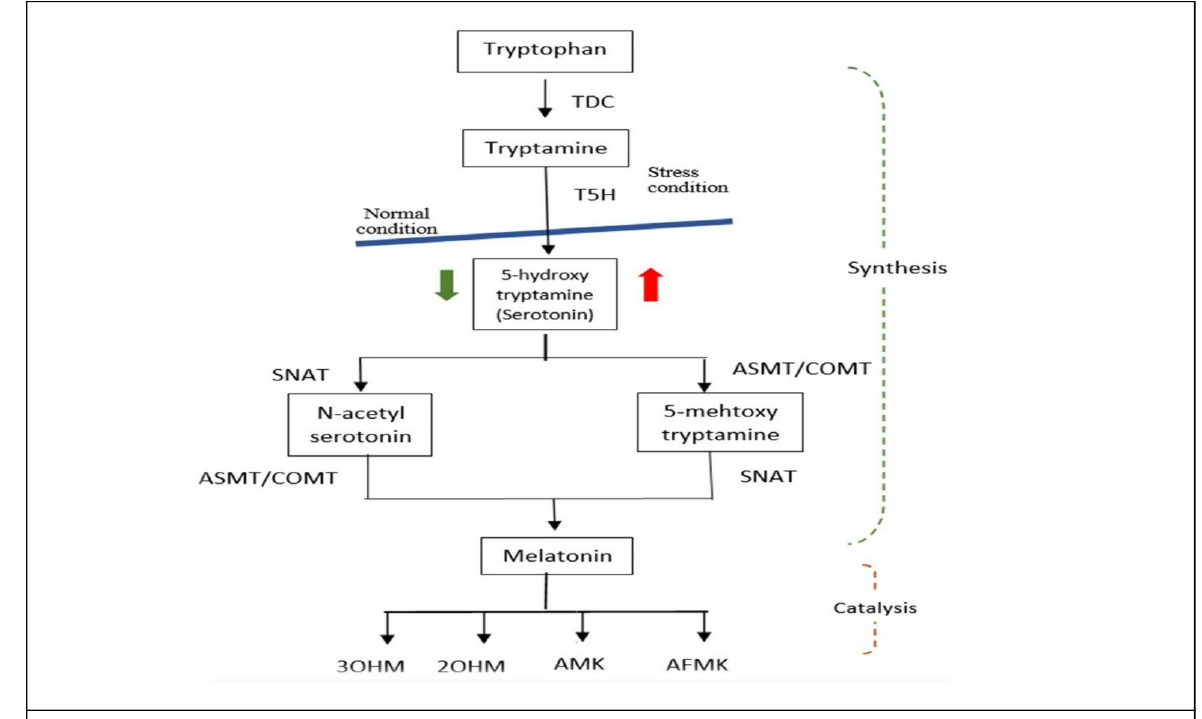
Figure 1: Biosynthetic pathway of melatonin under normal and stressed condition Note: TDC = Tryptophan Decarboxylase; T5H = Tryptamine 5-Hydroxylase; SNAT =Serotonin N-Acetyl Transferase; ASMT = Acetyl Serotonin Methyl Transferase; COMT = Caffeic Acid O-Methyl Transferase; 3OHM = Cyclic